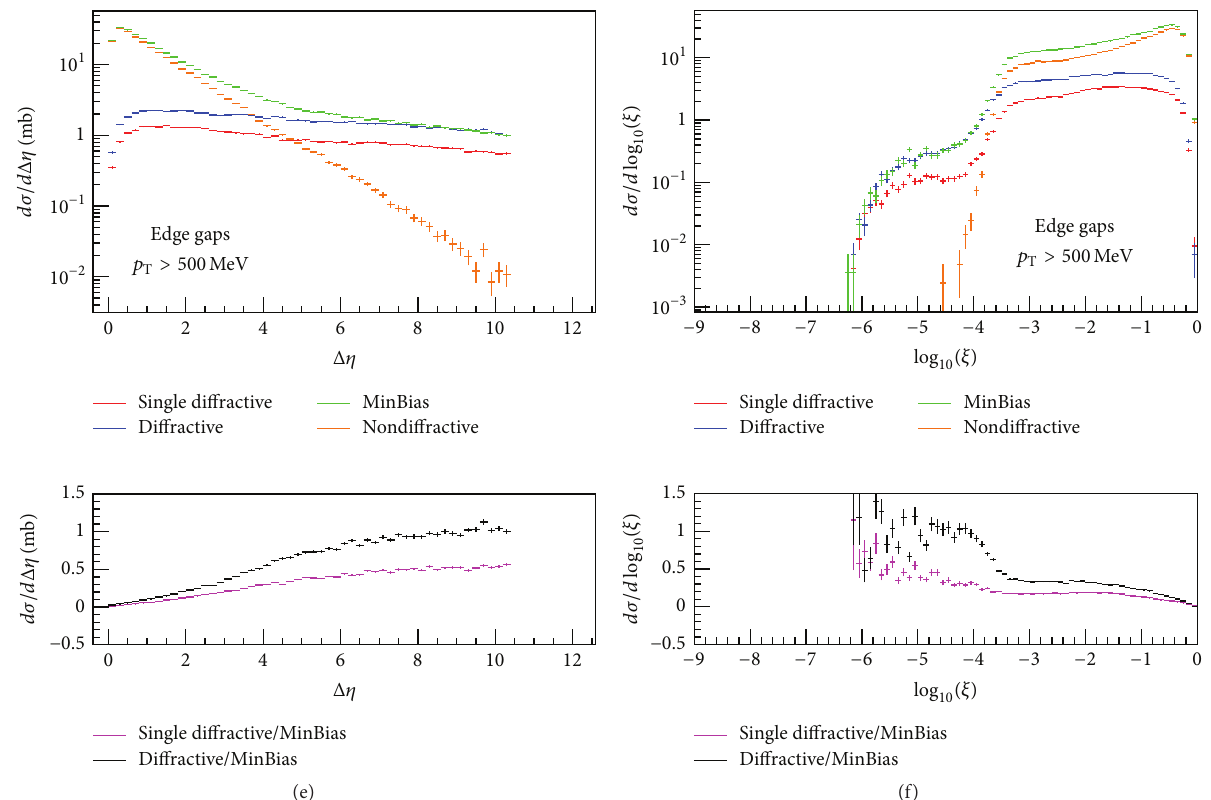
Figure 6: On the left side 𝑑𝜎/𝑑Δ𝜂 and on the right side 𝑑𝜎/𝑑 log 10 𝜉 for different event classes. Gap is defined as edge gap and no 𝑝 T cut (a, b), 𝑝 T > 200 MeV (c, d), and 𝑝 T > 500 MeV (e, f) cuts are applied for all final state particles in |𝜂| < 5.2 .